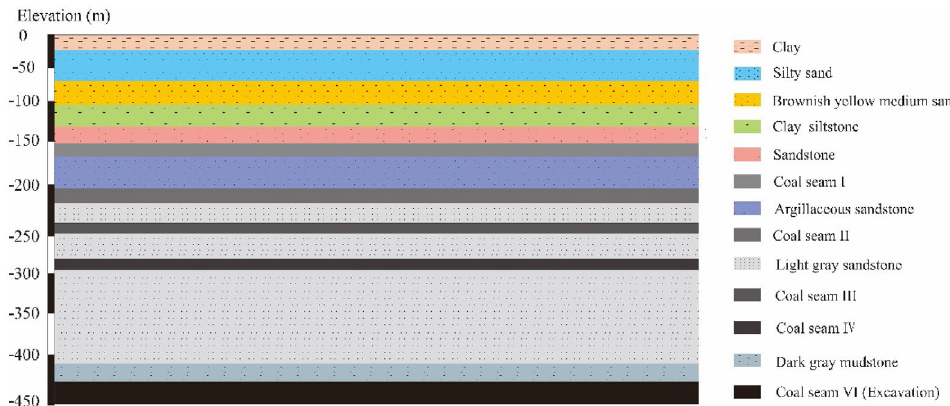
Figure 4. The Simplified geological section of Barapukuria Coal Mine.